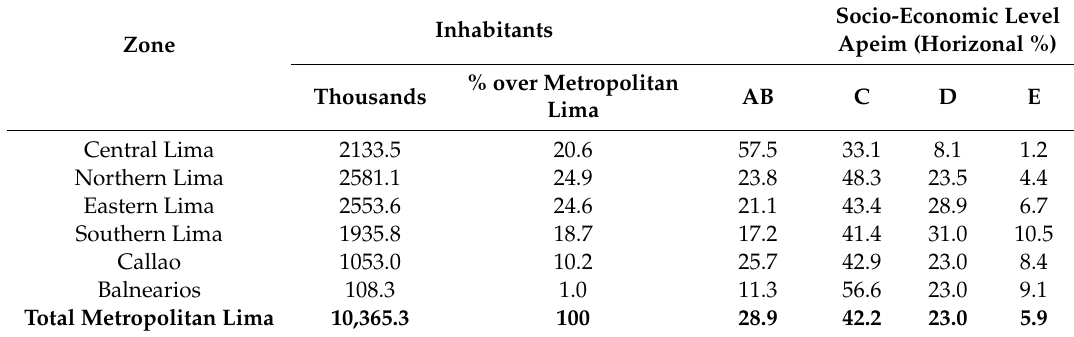
Source: Table by authors from data in Reference